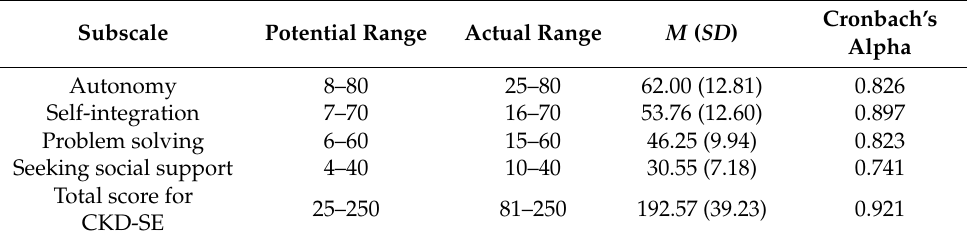
Table 2. Descriptive statistics and Cronbach’s alpha of the CKD-SE